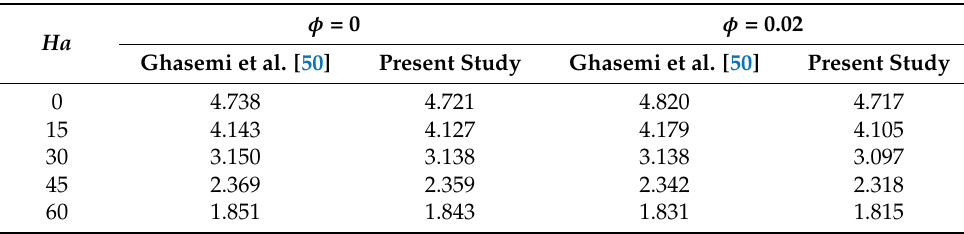
Table 2. Comparison of average Nusselt number ( Nu av ) of the current code with Ghasemi et al. [50] for different nanoparticles volume ( φ ), and Hartmann number ( Ha ) when Ra = 10 5 . φ = 0 φ = 0.02 Ha Ghasemi et al. [50] Present Study Ghasemi et al. [50] Present Study 0